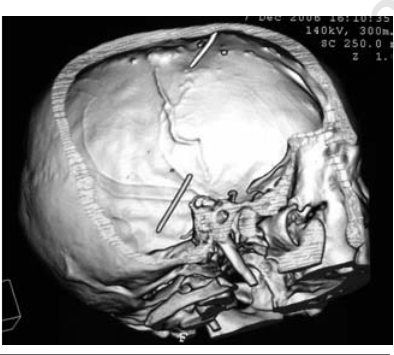
Figure 3. Three dimensional brain tomogra- phy showing the position of the 3